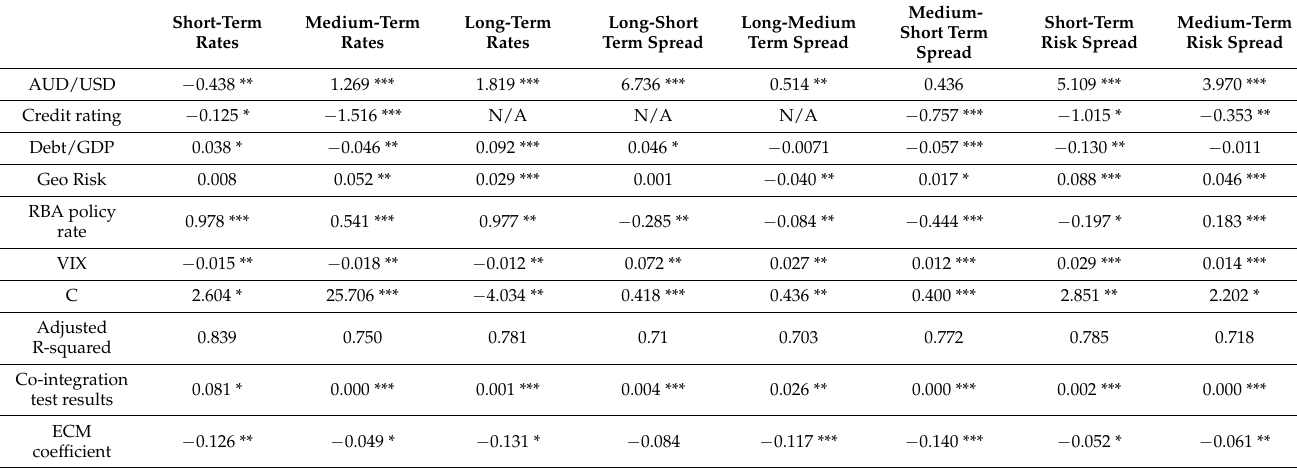
Table 3. Aggregate quantile regression